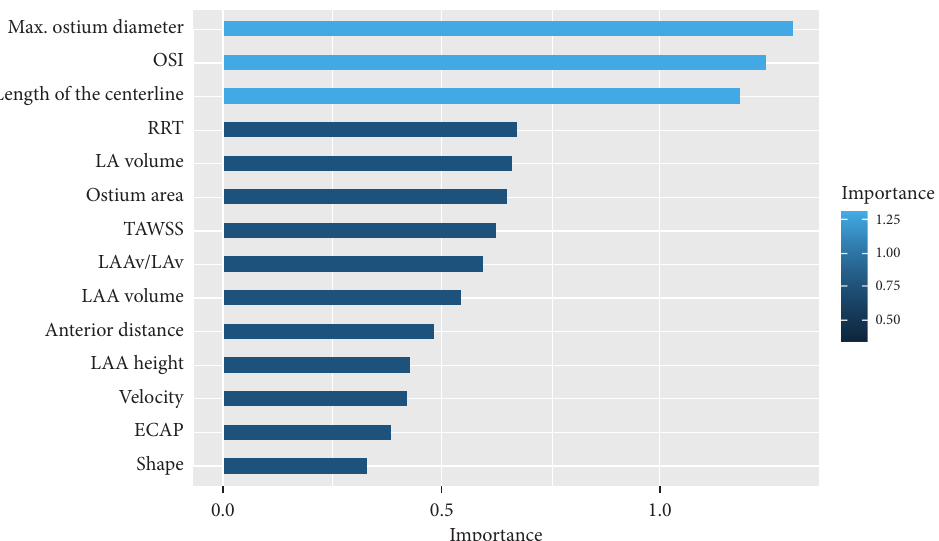
Figure 4: Model of the random forest performance in terms of Gini index. OSI: oscillatory shear index; RRT: relative residence time; LAAv: left atrial appendage volume; LAv: left atrium volume; TAWSS: time average wall shear stress; ECAP: endothelial cell activation